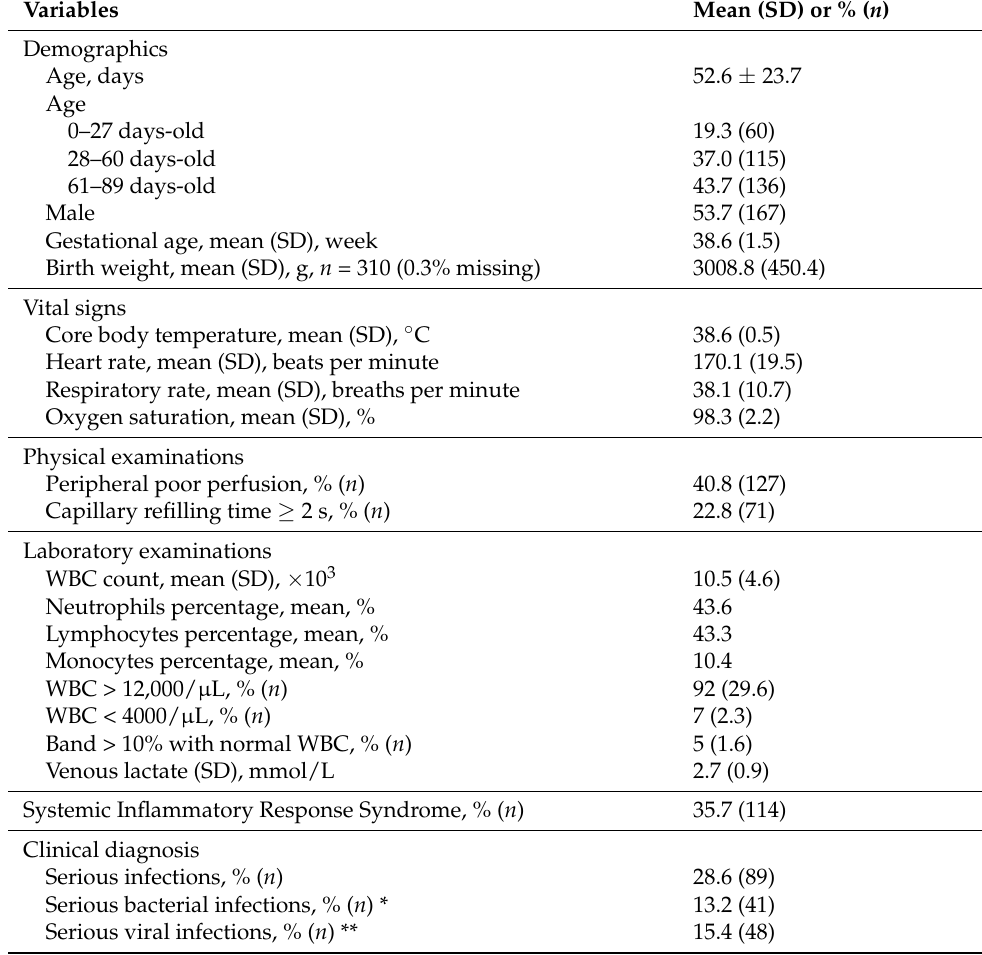
Figure 1. Derivation of study population. Table 1. Clinical characteristics of patients ( n = 311)